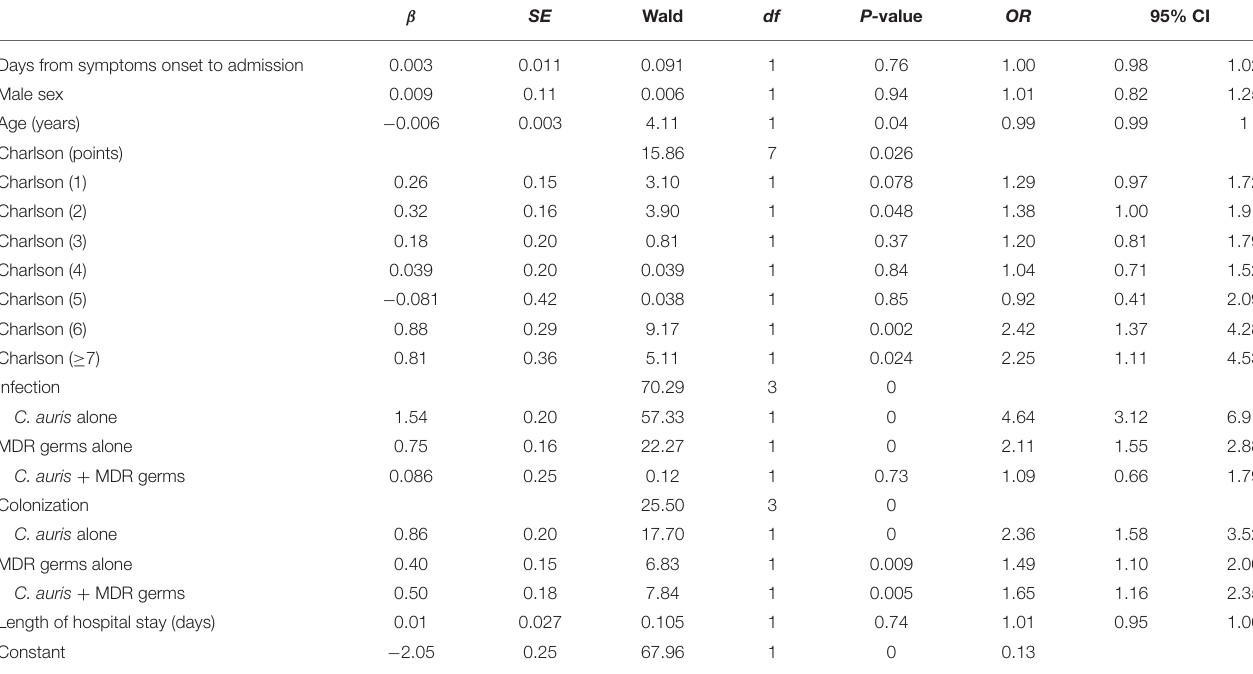
TABLE 5 | Multivariable logistic regression for mortality in total sample of patients admitted to hospital for COVID-19. β SE Wald df P- value OR 95% CI